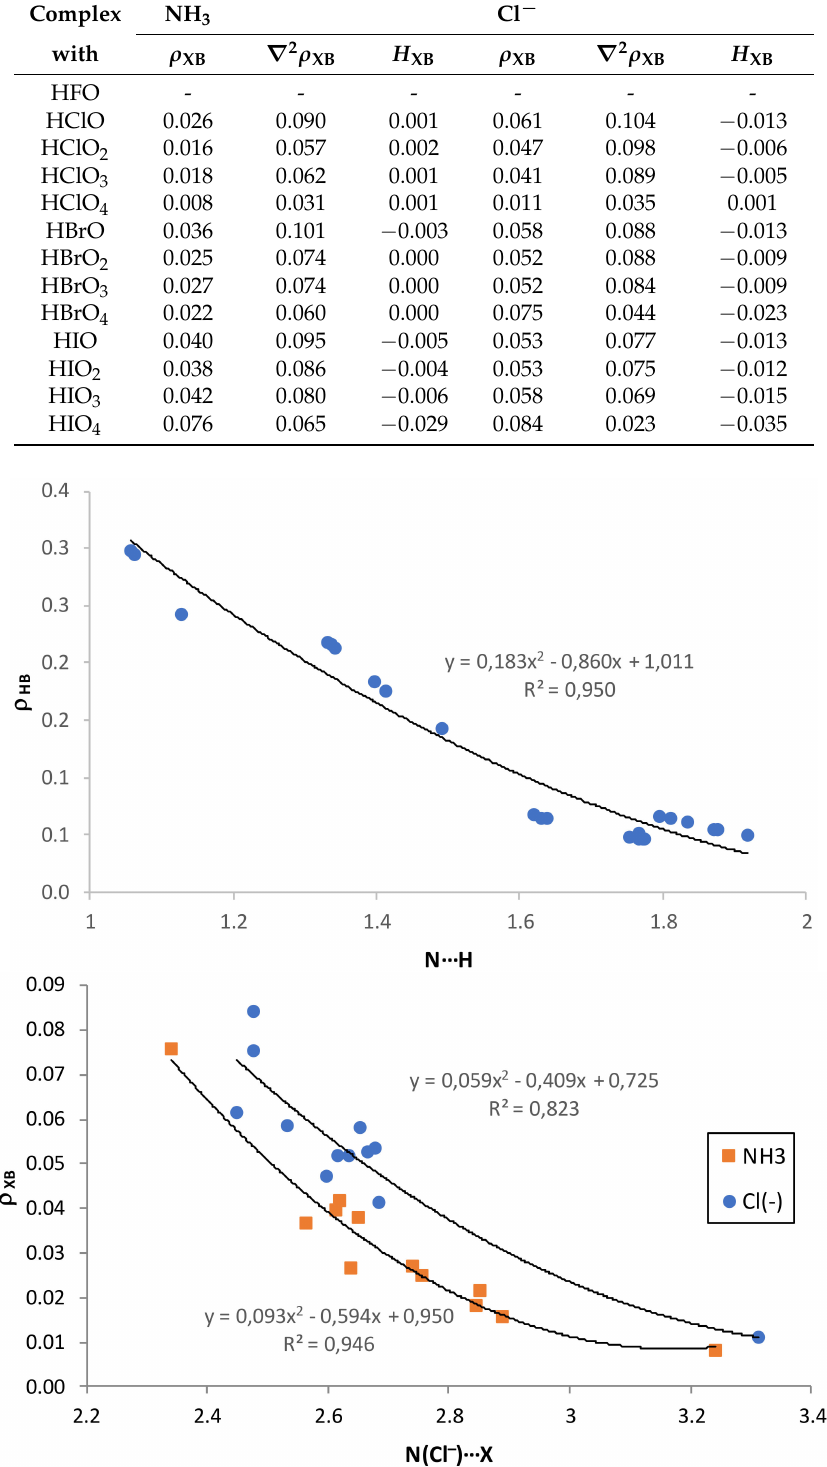
Figure 5. The second-order polynomial relationship between the intermolecular distance (in Å) and the electron density for HB, ρ HB , (up) and XB, ρ XB , (down)